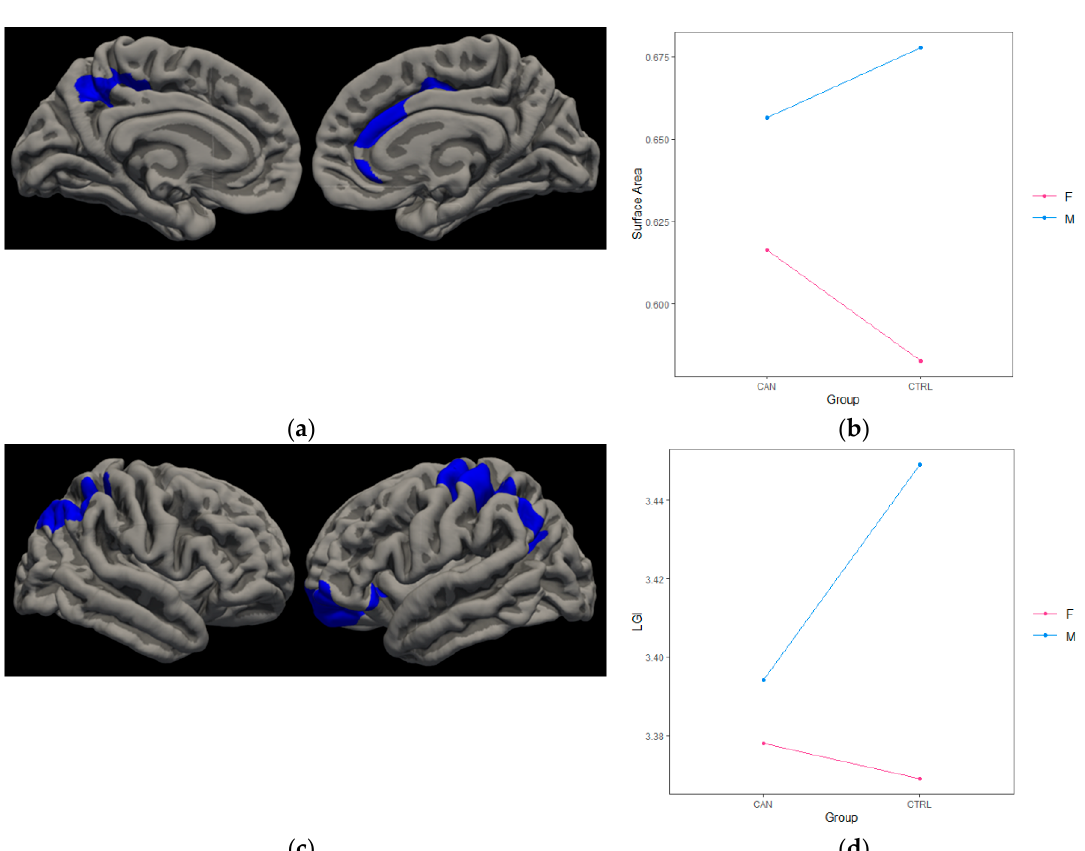
Figure 2. Cannabis*Gender Findings. ( a ) Medial view of significant interaction between cannabis group and gender in left cuneus, left rostral middle frontal (not pictured), and right superior frontal SA. ( b ) Generally, female cannabis users demonstrated more SA in these regions compared to non-using females, whereas male cannabis users demonstrated less SA compared to non-using males (left rostral middle frontal SA finding depicted). ( c ) Lateral view of significant interaction between cannabis group and gender in right supramarginal, left precentral, and left lateral orbitofrontal LGI. ( d ) Generally, female cannabis users had more LGI in this region compared to non-using females, whereas male cannabis users had less LGI compared to non-using males (left precentral LGI finding depicted).